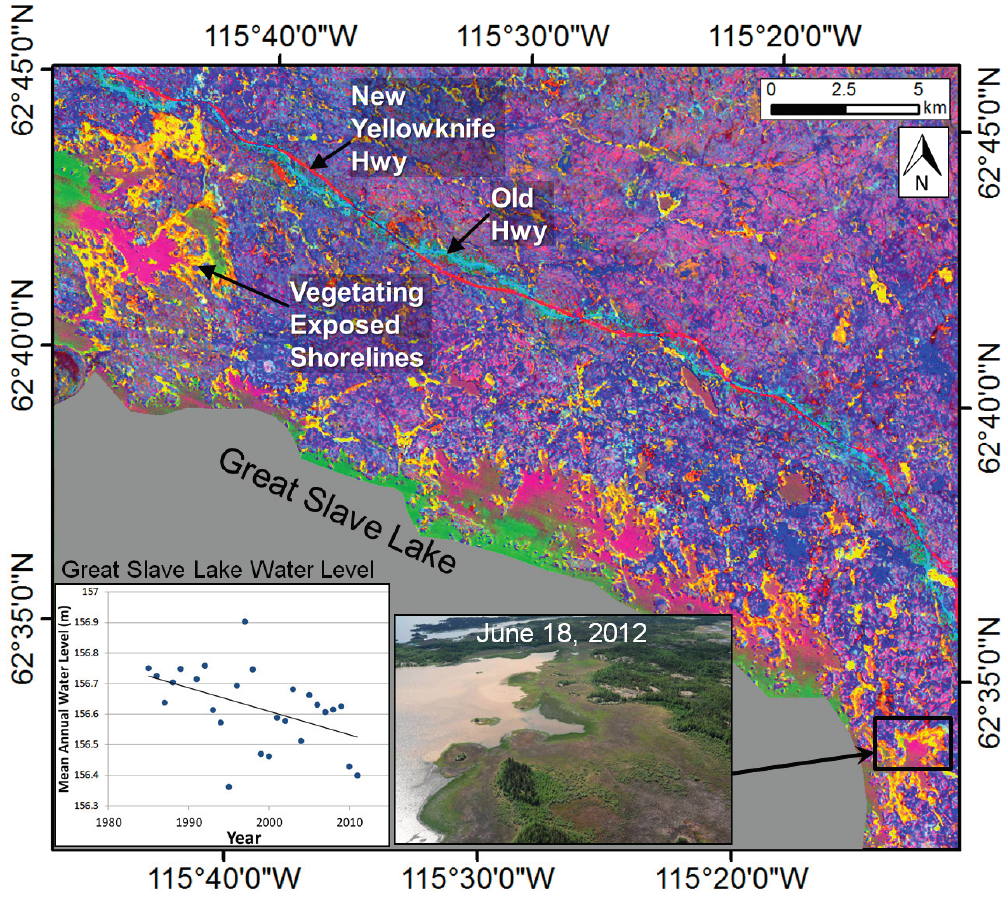
Figure 10. Area along the north shore of Great Slave Lake west of Yellowknife showing receding shorelines that are being colonized by vegetation in the TC trend image (yellow). The new Yellowknife Highway (red) and old highway where vegetation is regenerating (teal) are also visible. A photo captured from helicopter shows one of the bays with growth of new shoreline vegetation. Mean annual water levels from Environment Canada’s Hydrometric Data are shown for Great Slave Lake at Yellowknife Bay for the 1985–2011 Landsat analysis